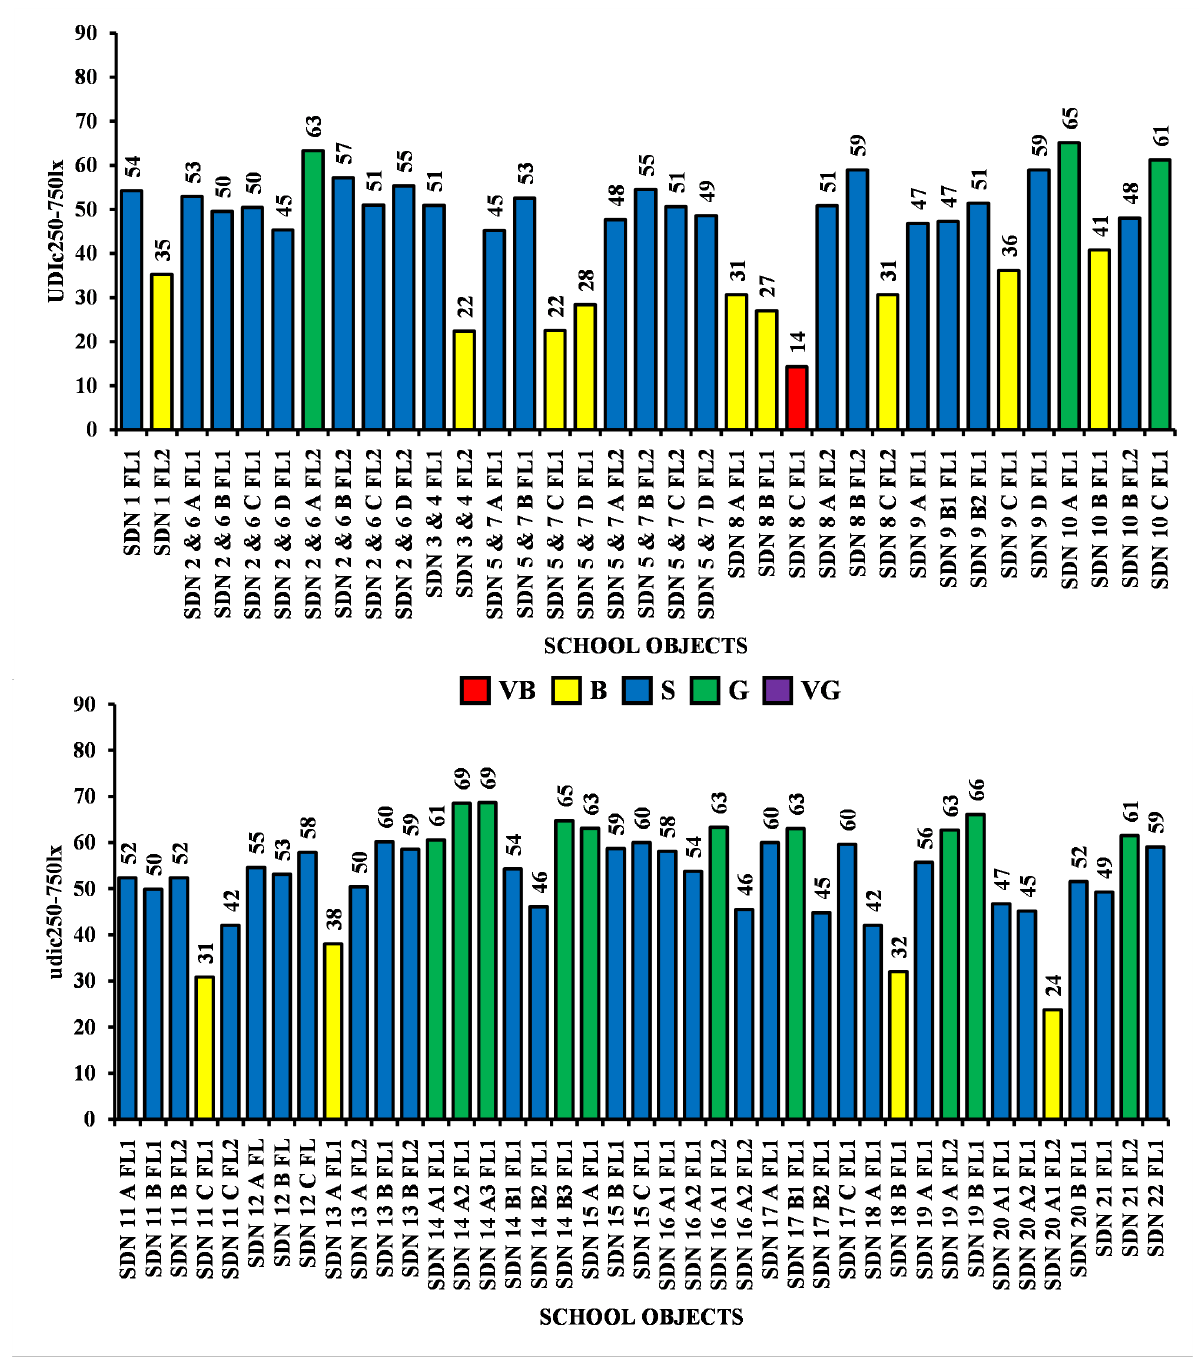
Fig. 2. Simulation result of UDI c 250 − 750 lx , for all school